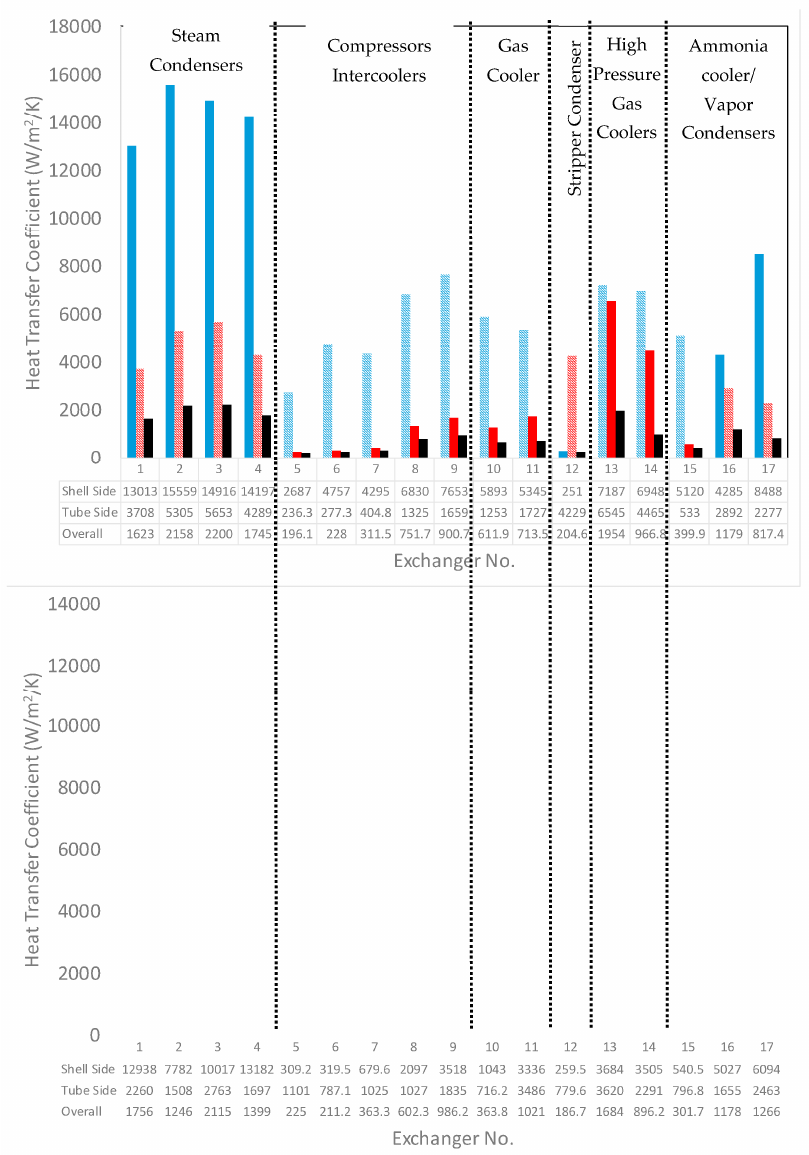
Figure 5. Heat transfer coefficient. Blue—shell side; red—Tube side, including the conductive heat transfer coefficient of tubes; black—overall heat transfer coefficient; striped bars—cooling water side. A fouling resistance of 0.00022 m 2 /W/K is assumed for the cooling water side. Top—original water-cooled exchangers; bottom—exchanger for the proposed cycle.